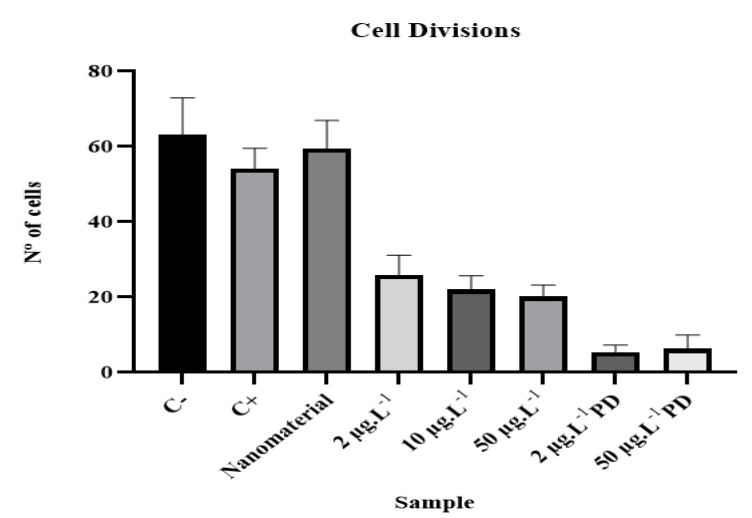
Figure 4. Average values and standard deviations in cell division of analyzed samples